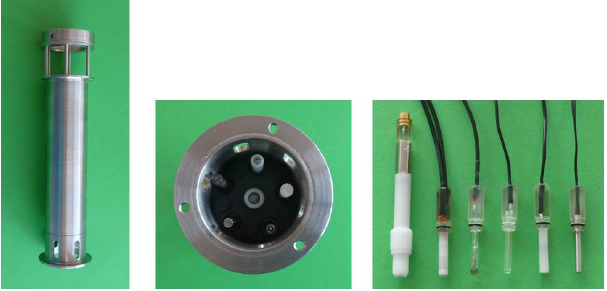
Figure 2. Left: multi-sensor probe; middle: top view of the multi- sensor probe; right: miniaturised electrodes (from left to right: car- bon dioxide sensor, oxygen sensor, pH electrode, redox electrode, reference, temperature